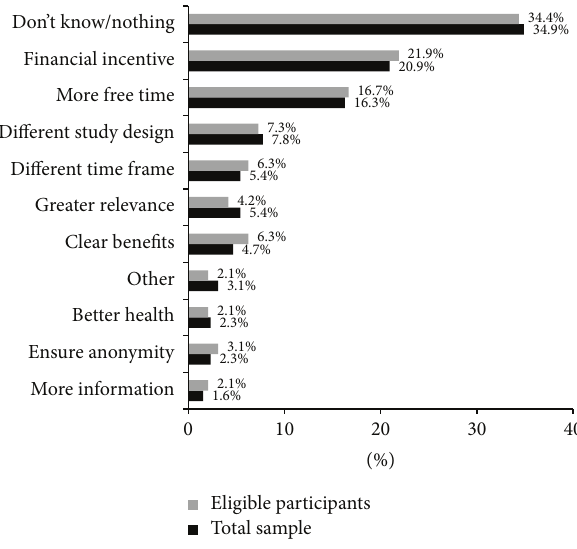
Figure 3: Factors reported as encouraging